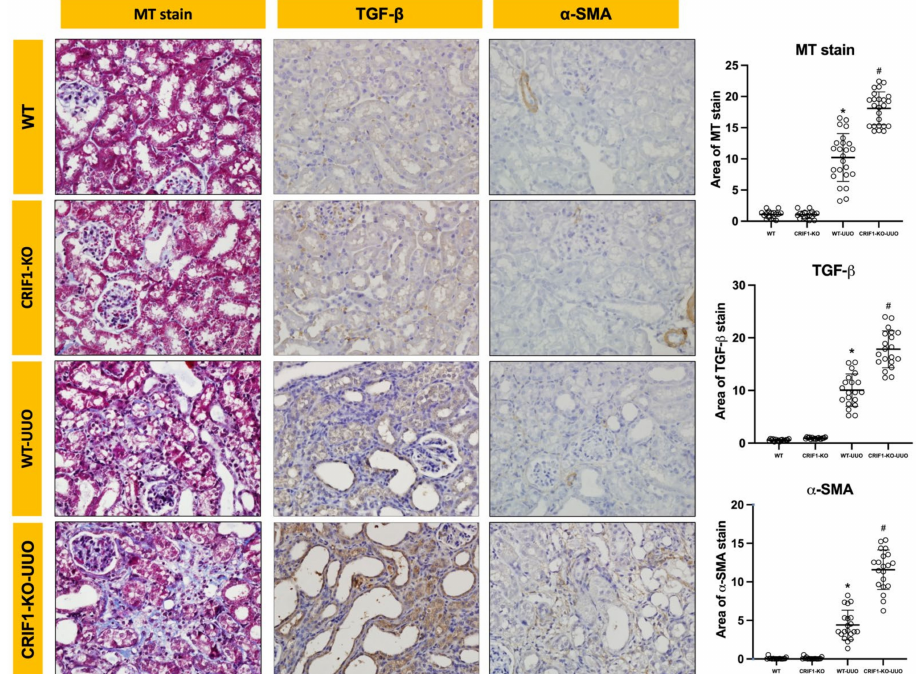
Figure 7. Photos of Masson’s trichrome and immunohistochemical stains of TGF- β and α -SMA. CR6-interacting factor-1 knockout (CRIF1-KO)-unilateral ureteral obstruction (UUO) kidneys showed an increase in the stained areas of TGF- β and α -SMA and Masson’s trichrome-stained area compared with wild-type (WT) UUO kidneys. * p < 0.05, WT-sham vs. WT-UUO; # p < 0.05, WT-UUO vs. CRIF1-KO-UUO.